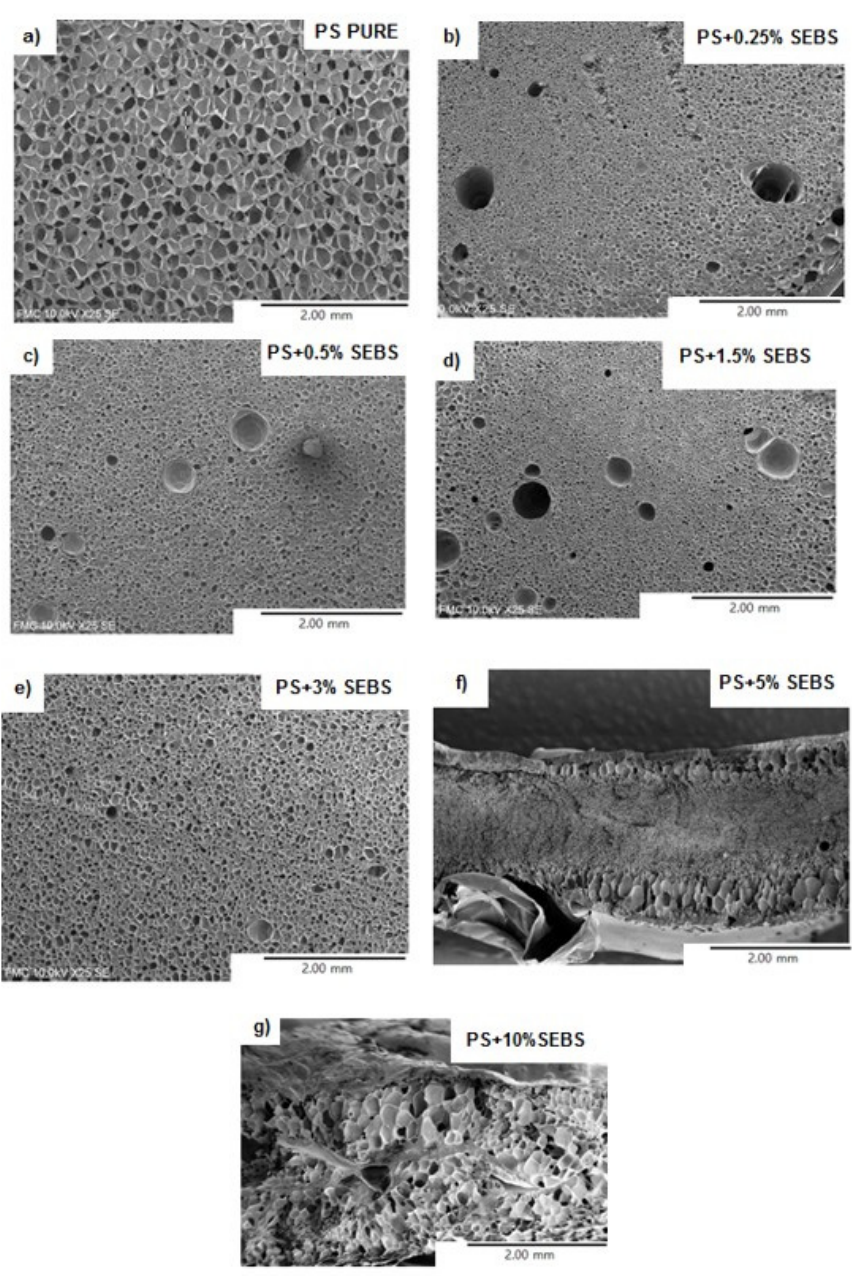
Figure 3. SEM micrographs of the cellular materials produced. ( a ) Pure PS; ( b ) PS + 0.25% SEBS; ( c ) PS + 0.5% SEBS; ( d ) PS + 1.5% SEBS; ( e ) PS + 3% SEBS; ( f ) PS + 5% SEBS; ( g ) PS + 10% SEBS.